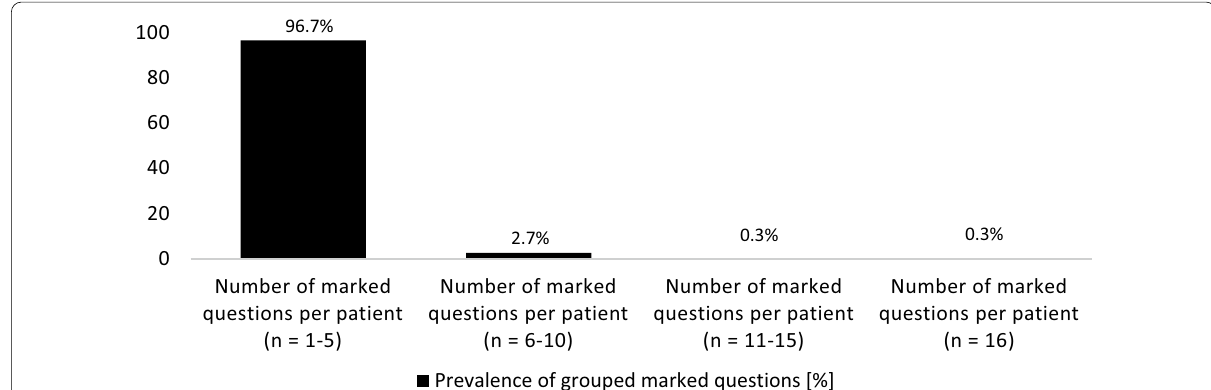
Fig. 3 Grouped prevalence [%] of marked questions (total marked questions in the study cohort n patients with marked questions mostly had n inquiries ( n 1; 0.3%), or 16 inquiries ( n =